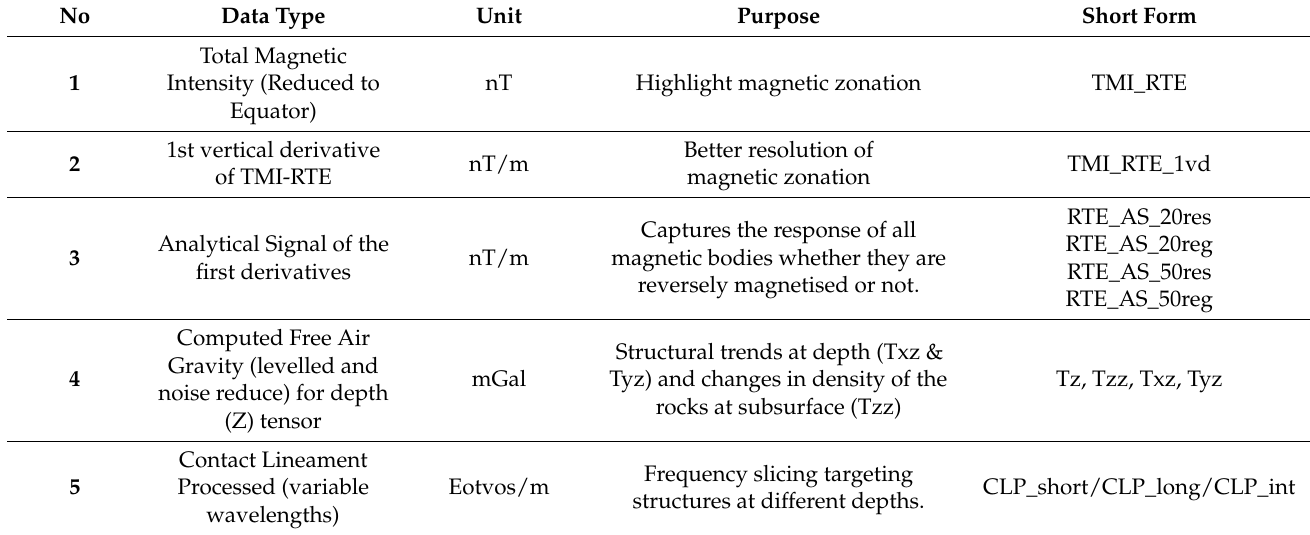
Table 1. Data components derived from the Air-FTG ® acquisition and their purposes in geological